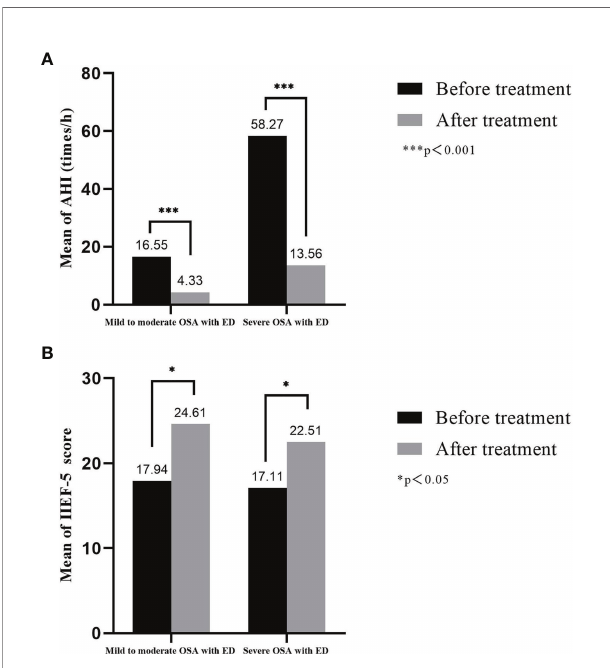
FIGURE 7 | Treatment response of AHI and IIEF-5 score in OSA with ED. (A) Six months after UPPP surgical treatment, AHI values of patients with mild to moderate OSA and patients with severe OSA decreased; (B) The IIEF-5 of patients with mild to moderate OSA and patients with severe OSA score